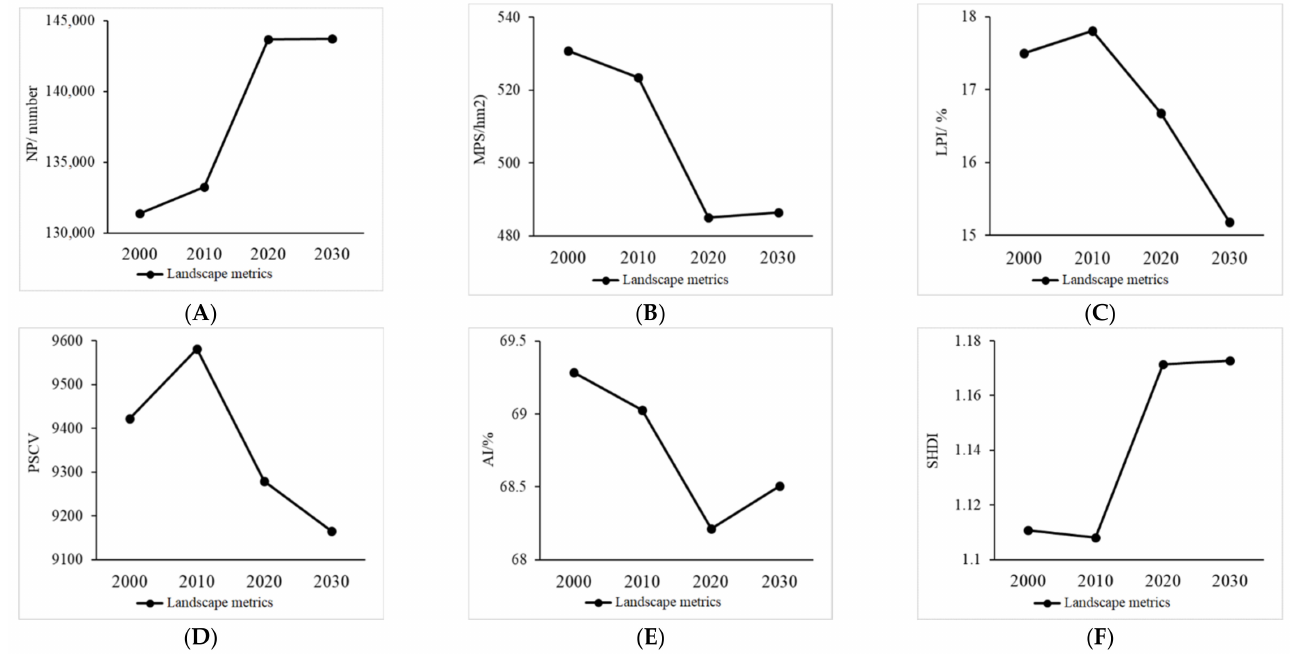
Figure 6. Changes in landscape metrics from 2000 to 2030. ( A ) NP; ( B ) MPS; ( C ) LPI; ( D ) PSCV; ( E ) AI; ( F )